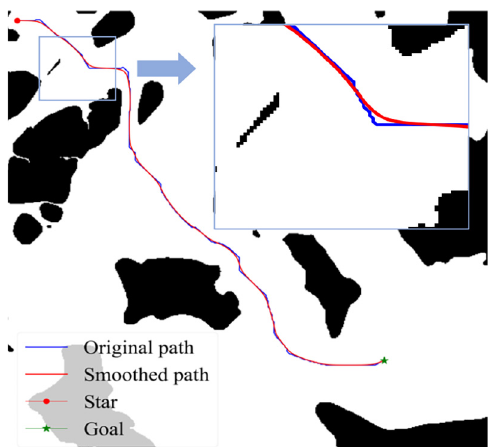
Figure 10 Smoothing effect displayed under improved A (cid:1)